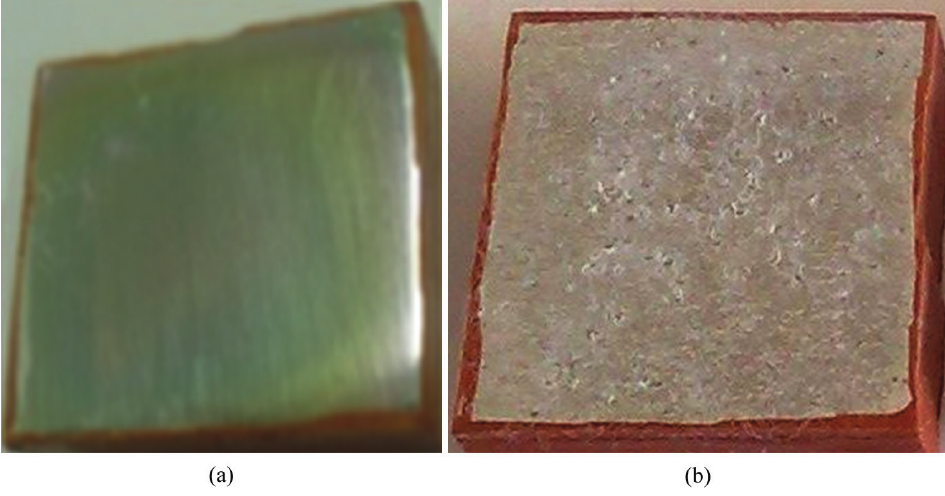
Figure 9. (a) Surface of the sample containing the film deposited in plasmas of 10 W of power, before the test and (b) after 145 h of exposure to salt